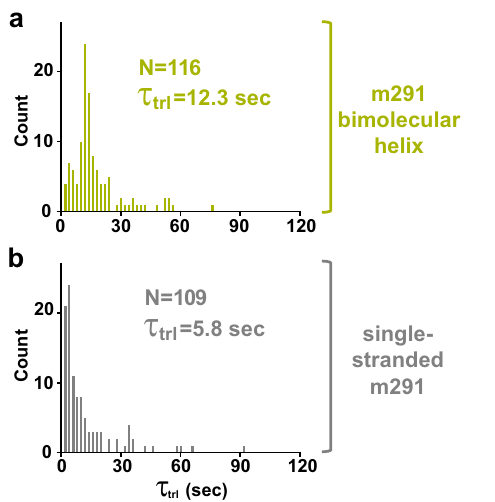
Fig. 8 The bimolecular helix formed in the m291 mRNA at the entry to mRNA tunnel mildly inhibits translocation. Kinetics of translocation was measured by smFRET experiments with pre-translocation S6-cy5/L9-cy3 ribosomes programmed with m291 mRNA containing a 16-bp bimolecular RNA helix (Fig. 1) positioned 11 nucleotides downstream of P-site codon ( a ) or with single-stranded m291 mRNA ( b ). Histograms (2 s binning size) show the distributions and median values of τ trl , which represents the dwell time between injection of EF-G GTP and ribosome translocation. N indicates the number of FRET traces compiled into each histogram. Source data are provided as a Source Data fi le. PRF decreased to ~18% (Fig. 9), demonstrating that the FSS sti- mulates ribosome frameshifting.